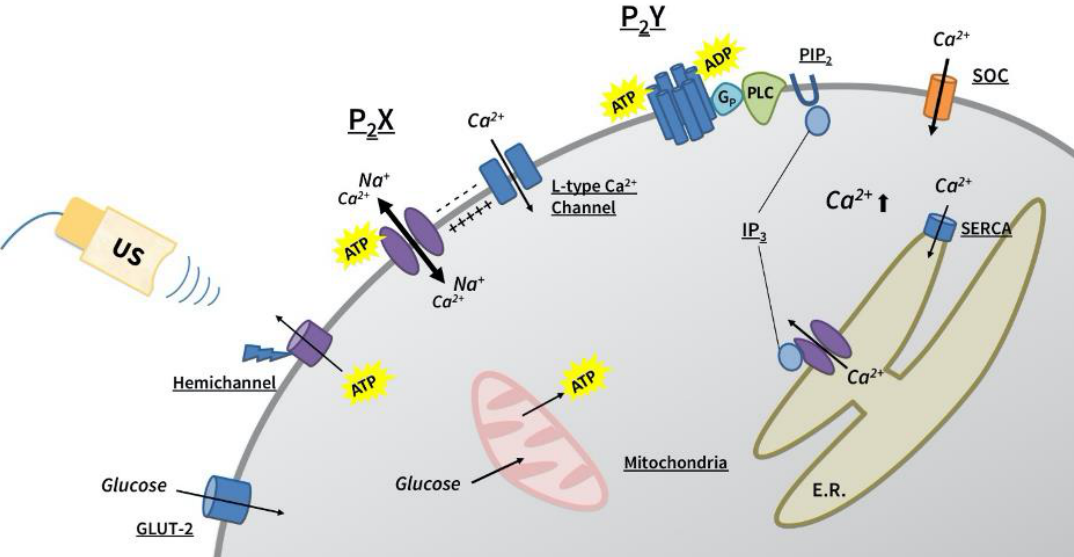
Figure 6. A schematic drawing representing the proposed pathways of ultrasound-evoked Ca 2 + dynamics in the HIT-T15 cells. Mechanosensitive hemichannel releases ATP and / or ADP into extracellular space in response to ultrasound stimulation, which in turn activates both P 2 receptors. Depending on the amount of released ATP or ADP, the two subtypes of P 2 receptors, P 2 X and P 2 Y, will be activated in a competitive manner, evoking either fast-irregular or slow-periodic Ca 2 + oscillations,